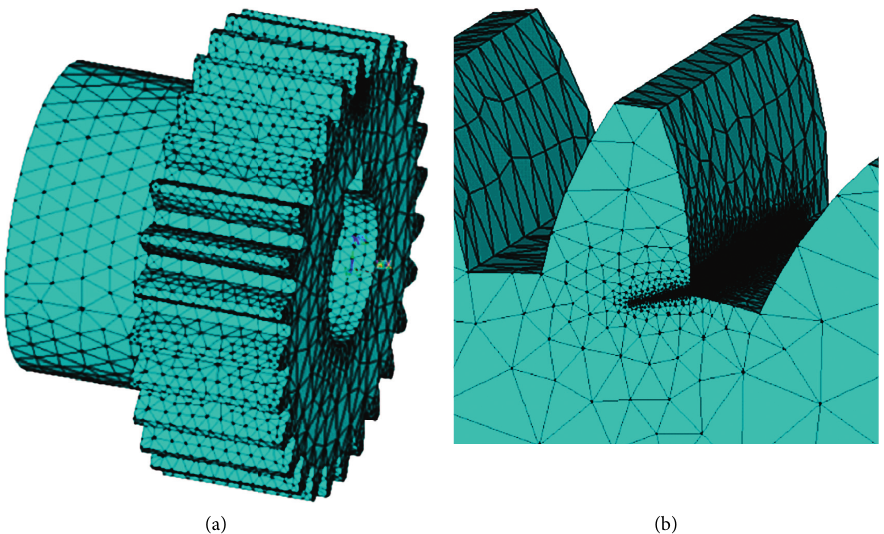
Figure 6: Mesh model of sun gear. (a) Entire mesh. (b) Crack